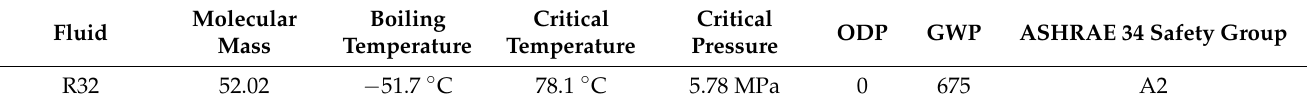
Figure 1. Schematic diagram of the air source transcritical CO 2 heat pump water heater. The property of R32 is summarized in Table 1. Table 1. The specific properties of environmental refrigerant R32.